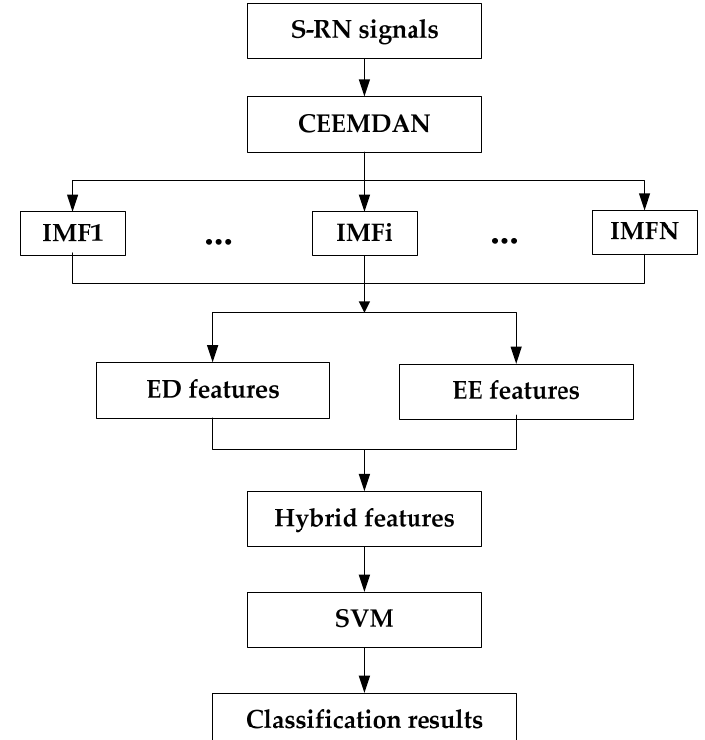
Figure 1. The flowchart of the hybrid energy feature extraction approach; S-RN: ship-radiated noise, CEEMDAN: complete ensemble empirical mode decomposition with adaptive noise; IMF: intrinsic mode function, ED: energy difference, EE: energy entropy, SVM: support vector machine.